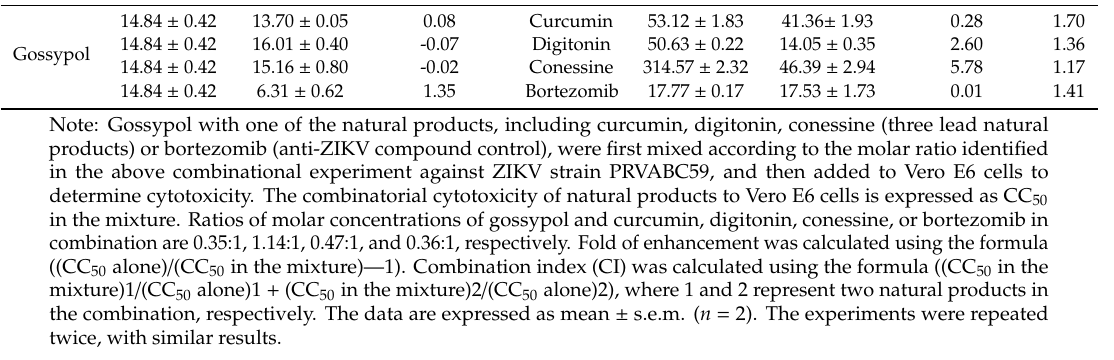
Fold of Enhancement In Mixture Alone In Mixture